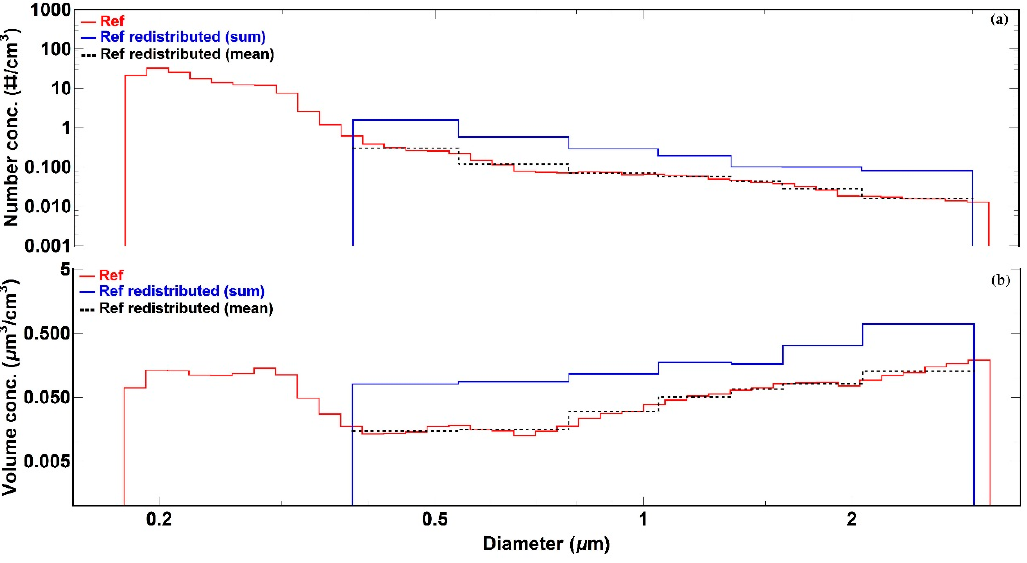
Figure 4. Illustration of Palas Fidas 200 S measurements redistributed into the Alphasense OPC-N2 size bins for all bins contributing to PM 2.5 for ( a ) number concentration data and ( b ) volume concentration data. The black dashed lines represent the average Palas Fidas 200 S measurements in each Alphasense size bin.